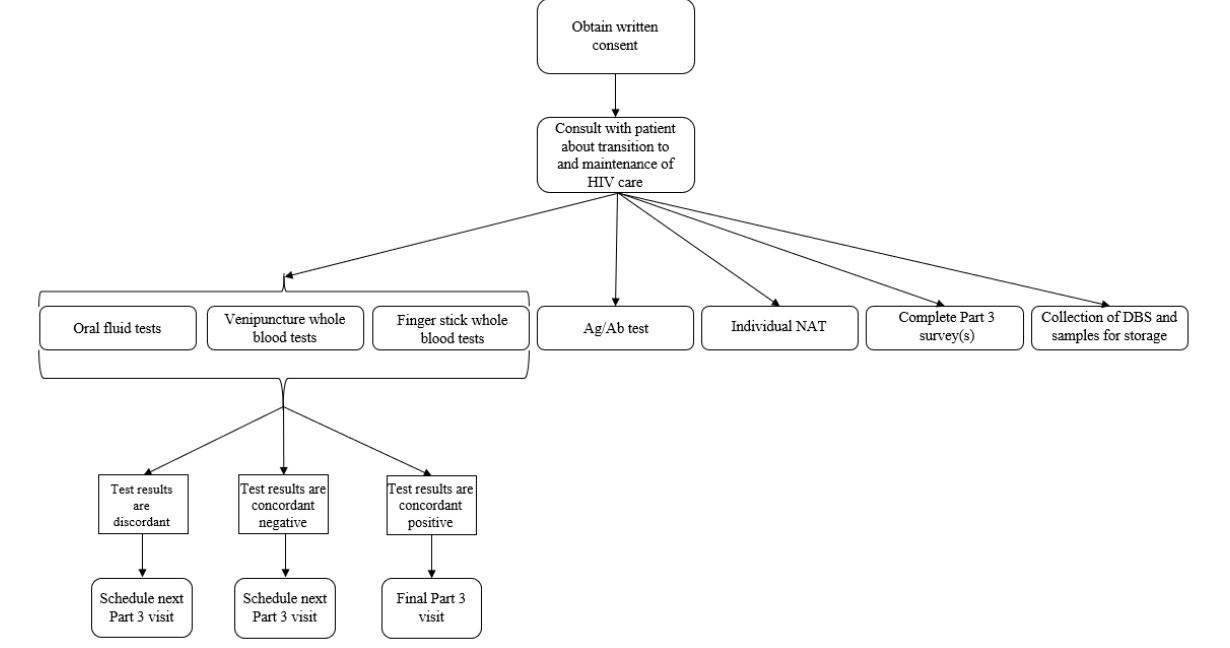
Figure 2. Project DETECT part 3 procedures. Ag/Ab: antigen/antibody; NAT: nucleic acid test; DBS: dries blood